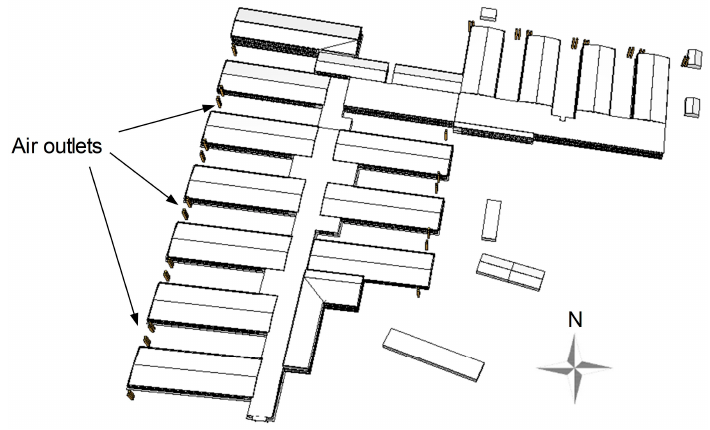
Figure 17. FDS model of the Wuhan Huoshenshan Hospital.